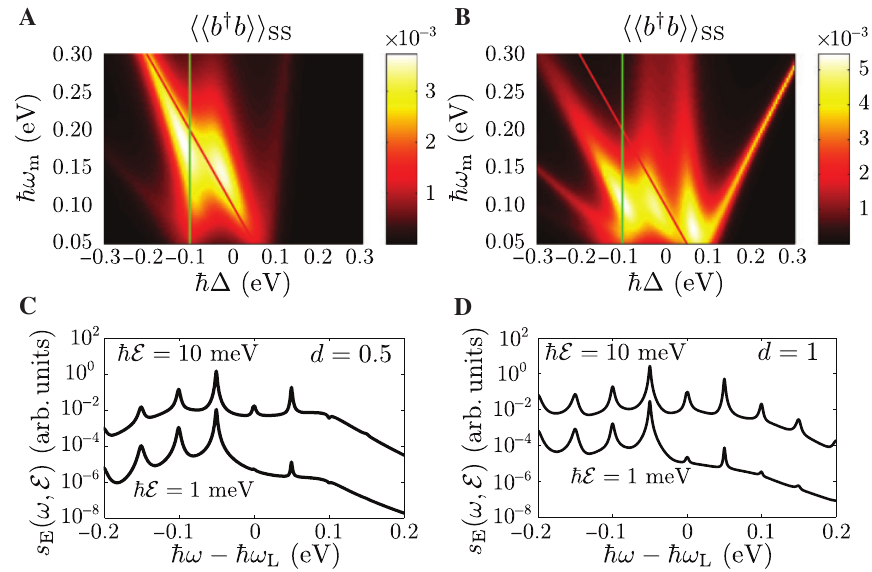
for an electron– m = 2 meV, ħ γ = 2 × 10 − 5 eV, σ b